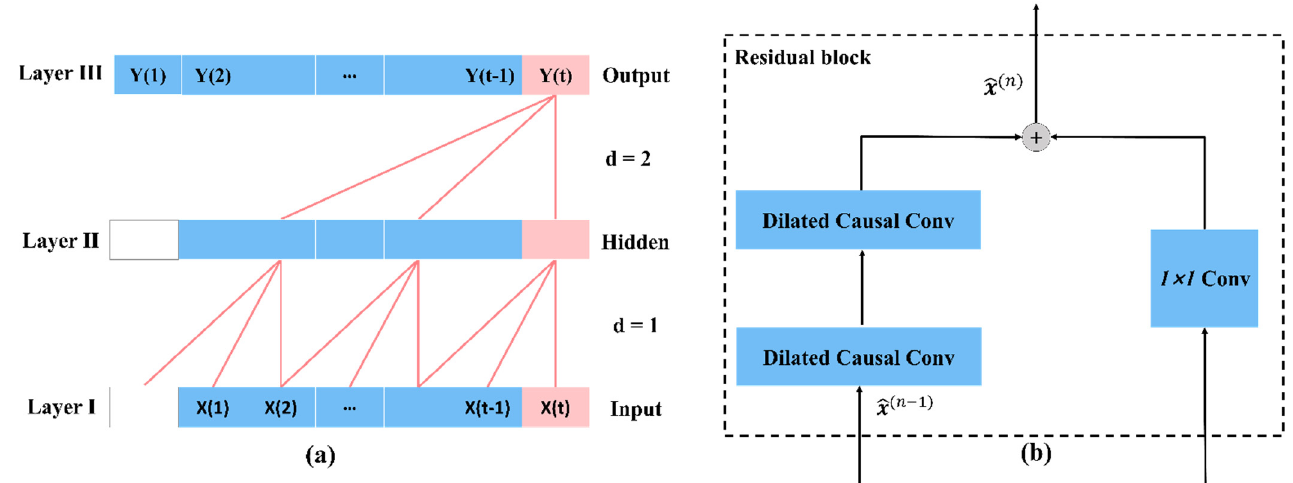
Figure 3. Structural elements in DFTrans. ( a ) Dilated causal convolution where the perceptual field can cover the input sequence. ( b ) To keep the size of the input and output the same, add a 1 × 1 convolution.